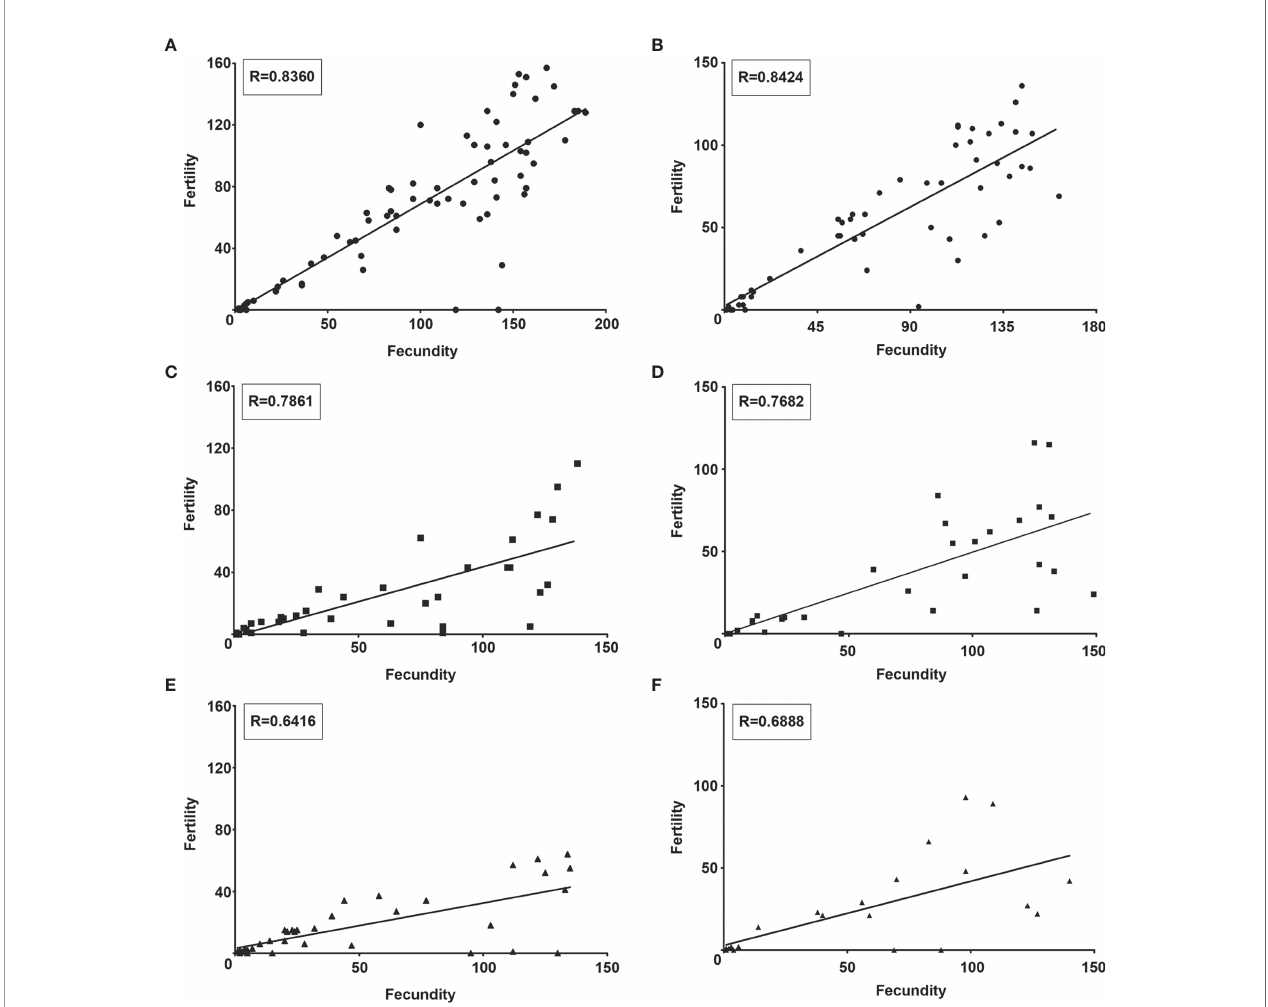
FIGURE 10 | Strigomonas culicis infection impaired the correlation between fecundity and fertility in Aedes aegypti females. Correlation analysis of (A, B) non- infected and (C, D) wild type (WT)- and (E, F) hydrogen peroxide (H 2 O 2 )-resistant (WTR)- infected females fed with (A, C, E) 10% sucrose or (B, D, F) 10% sucrose + 5 mM sodium L-ascorbate (ASC) ad libitum . Analysis was made by Correlation of Spearman using data of two independent experiments. R value of each correlation is described in the